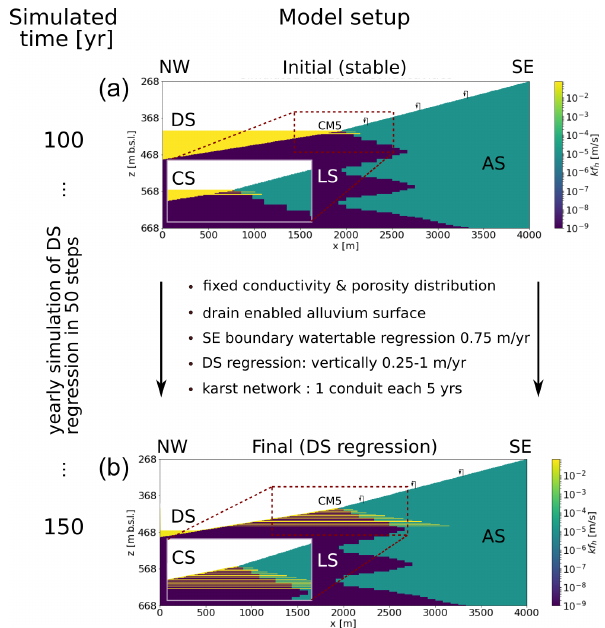
Figure 5. 2D hydrogeological model and simulation time setup. The hydrogeological unit abbreviations are DS – Dead Sea, AS – allu- vial sediments, LS – lacustrine sediments and CS – conduit system. Units are coloured by their horizontal hydraulic conductivity (kf h ). The text gives a description of the modelling approach between the initial (a) and final (b) states, the latter after 50 years of simulated DS regression. The simulated karst network evolution is presented as a zoomed-in view in the insets within each image. Top of al- luvium is considered freely draining. The top centre of the model corresponds roughly to the location of the outflow point of canyon CM5; the profile follows the NW section of the AA (cid:48) line of Fig. 3.